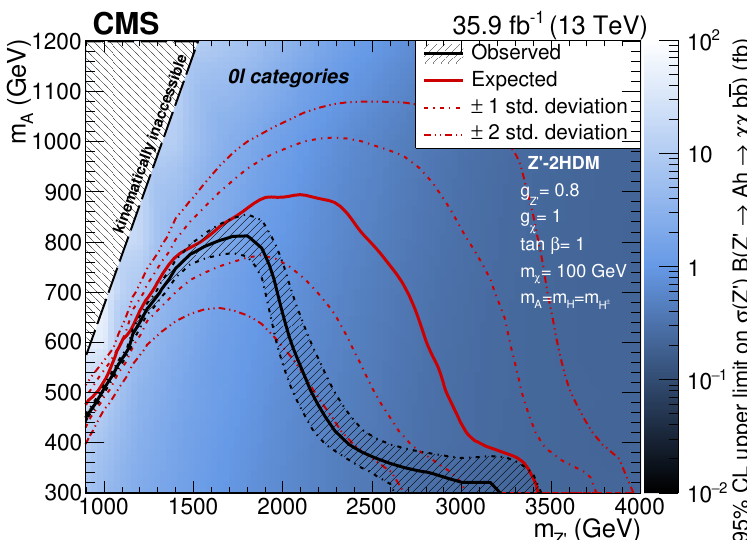
Figure 10 . Observed and expected exclusions in the parameter plane [ m Z 0 ; m A ] at 95% CL. The excluded regions in the considered benchmark scenario ( g Z 0 = 0 : 8, g (cid:31) = 1, tan (cid:12) = 1, m (cid:31) = 100 GeV, and m A = m H = m ) are represented by the areas below the curve. The hatched band relative H (cid:6) to the observed limit represents the uncertainty on the signal cross